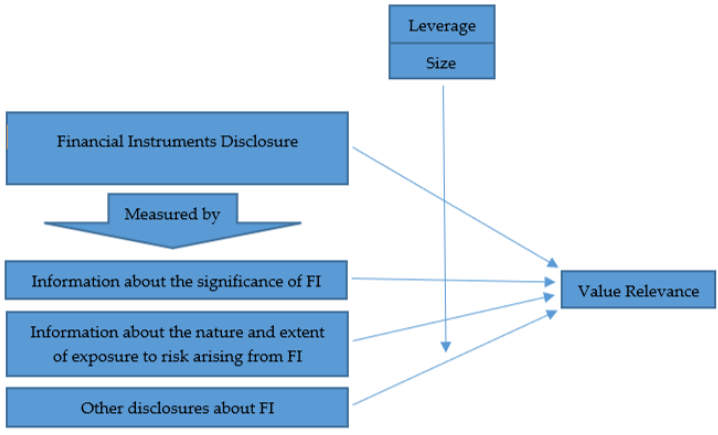
Figure 1. Depicts the research model. Source: developed by the